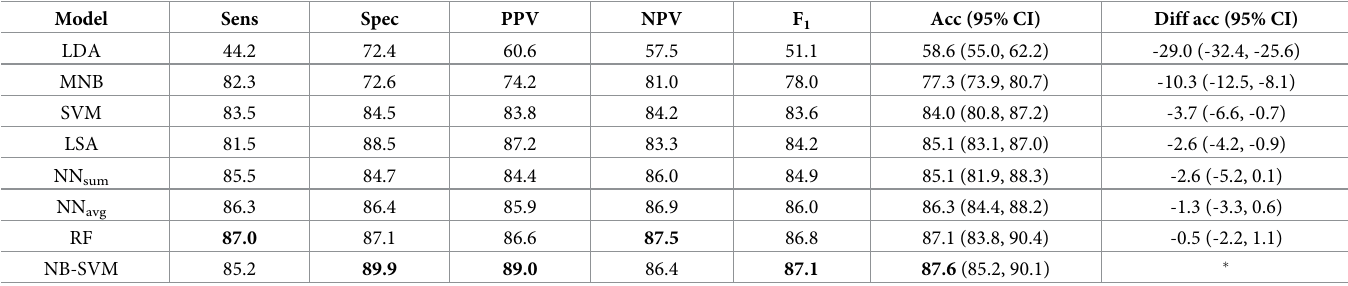
Table 2. Mean performance for our 8 models across the 10 train-test splits. Metrics include sensitivity (Sens), specificity (Spec), positive predictive value (PPV), nega- tive predictive value (NPV), F 1 , and accuracy (Acc), all shown as percentages. The best scores for each metric are shown in bold, and the final column presents differences in accuracy between each of the models and the most accurate model, the NB-SVM. Simultaneous confidence intervals are multiplicity-adjusted to control FWER.